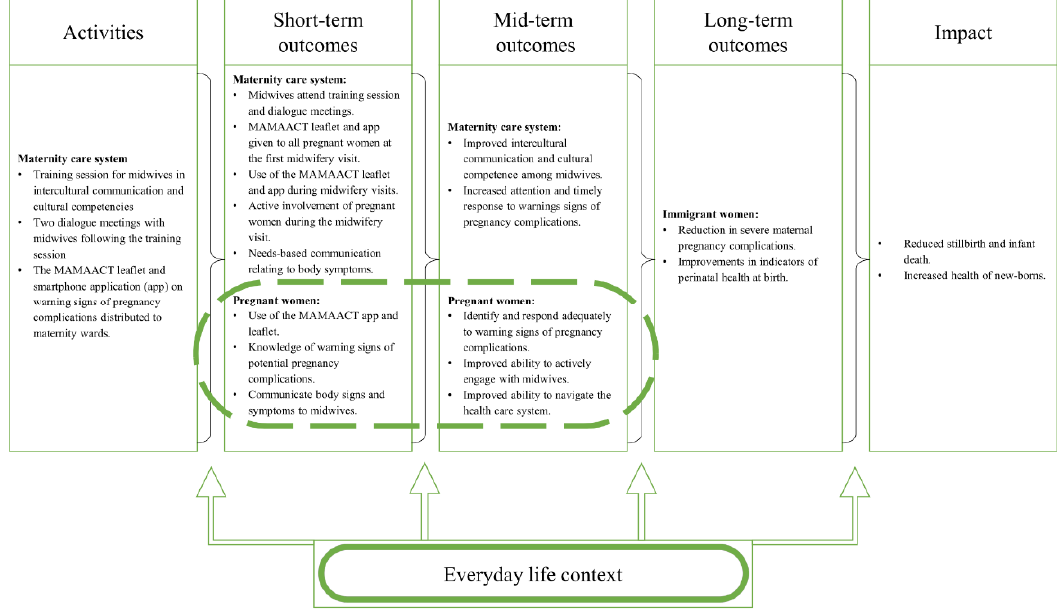
Figure 1. MAMAACT logic model and evaluation